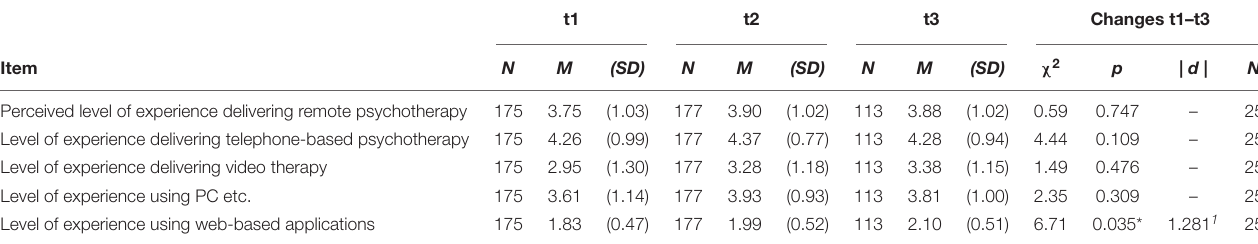
TABLE 2 | Changes to the perceived level of experience with remote psychotherapy, different media and modalities during the transition over all test periods. t1 t2 t3 Changes t1–t3